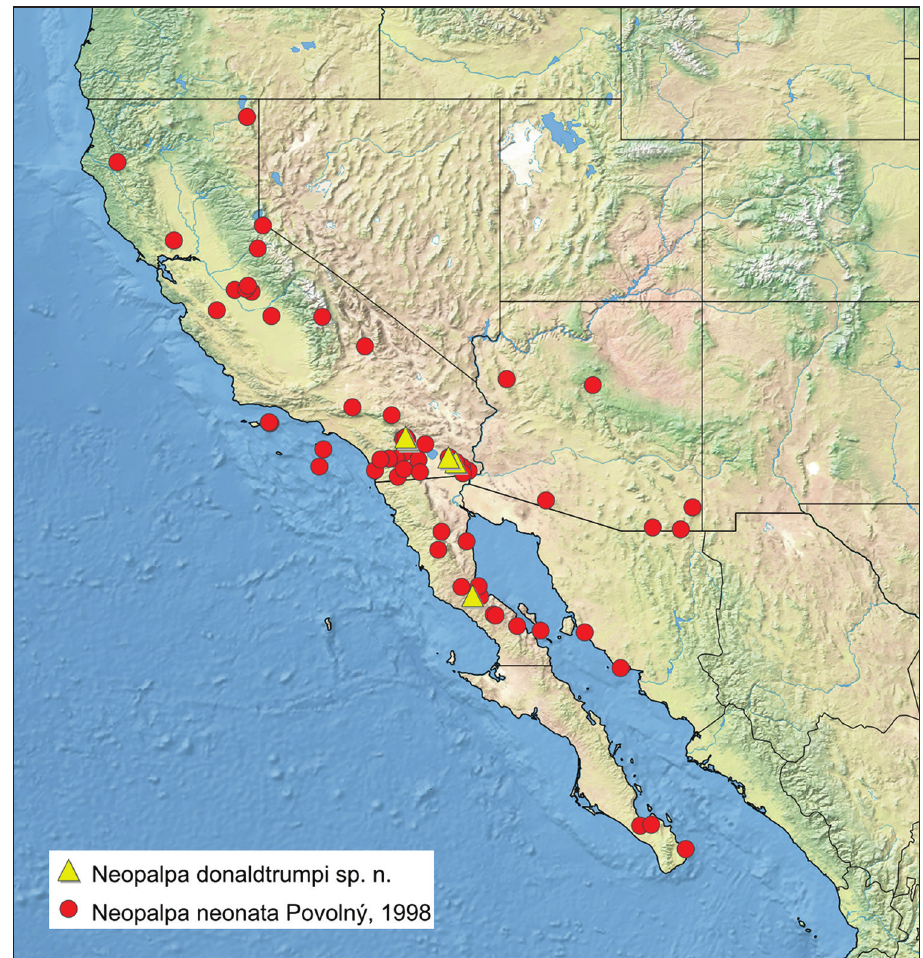
Figure 6. Distribution of Neopalpa species. (Created using simplemappr.net, accessed December 2016) DNA barcodes of N. neonata and N. donaldtrumpi are 4.9–5.1% divergent from